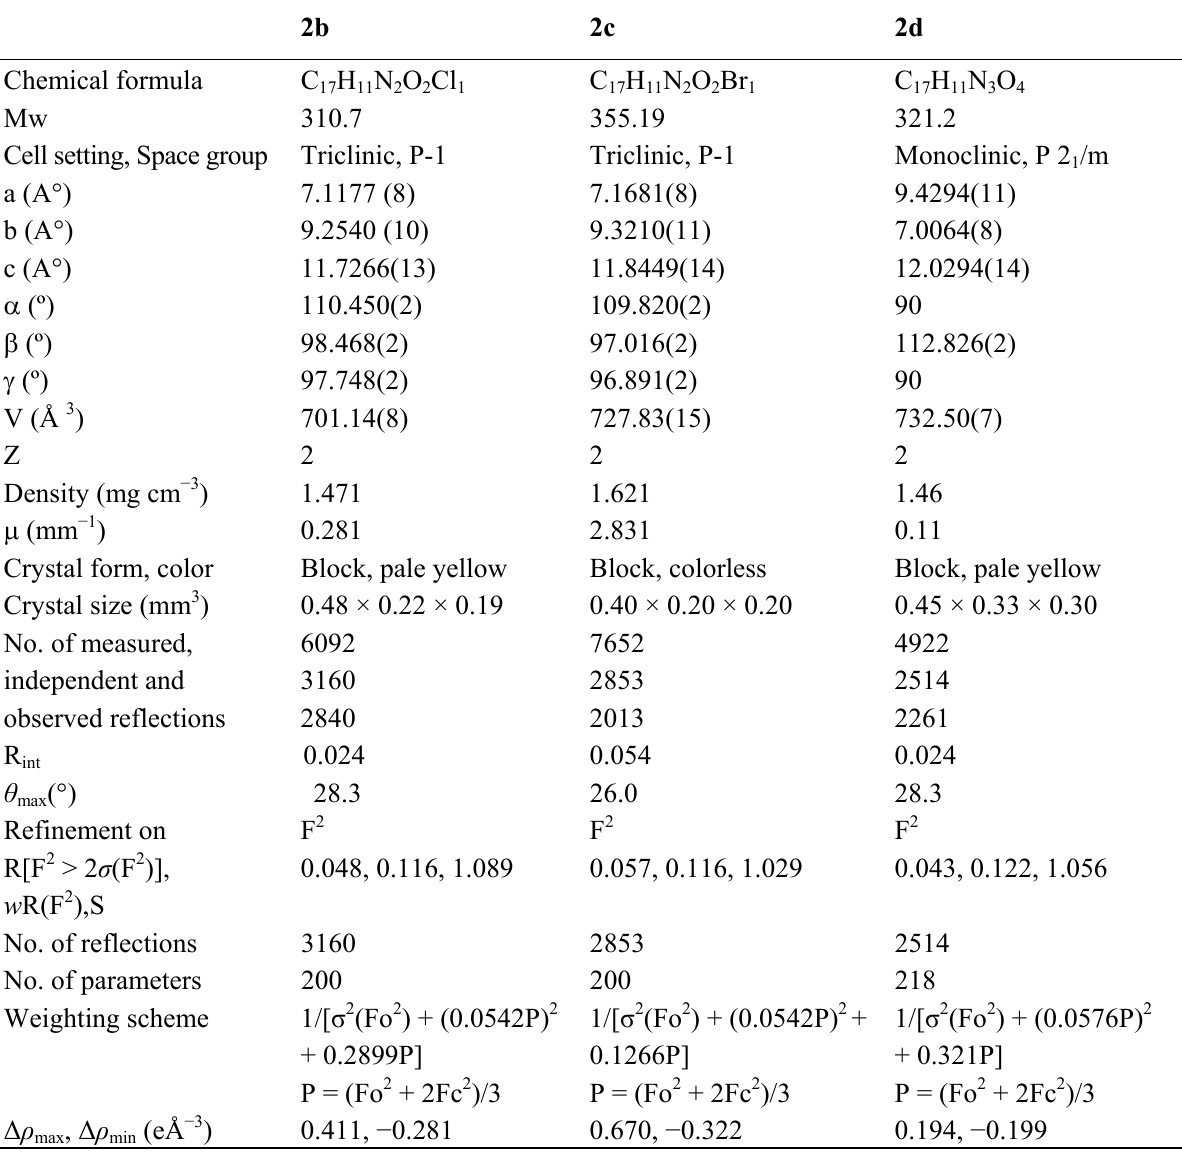
Table 6. Crystal data and structure refinement details for 2b-d